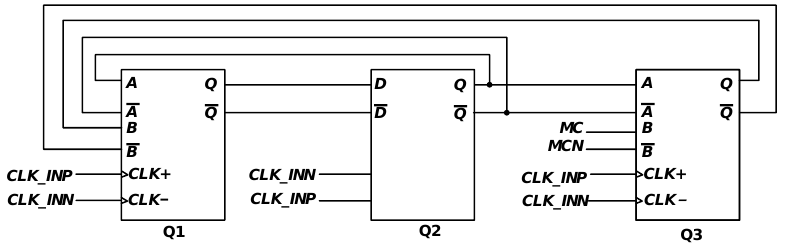
Figure 6. Schematic of the synchronous 4/5 frequency